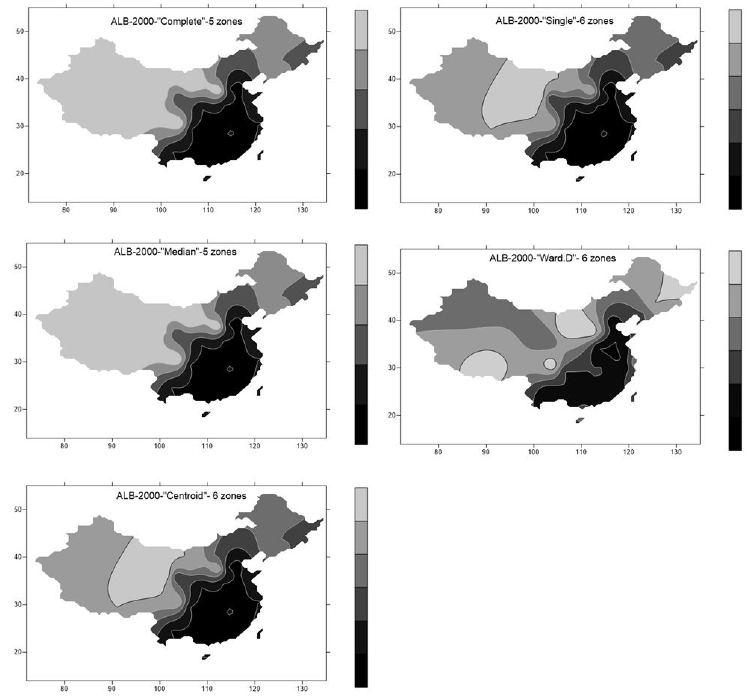
Figure 3. Classification of surface albedo (ALB) using 5 different methods (2000).